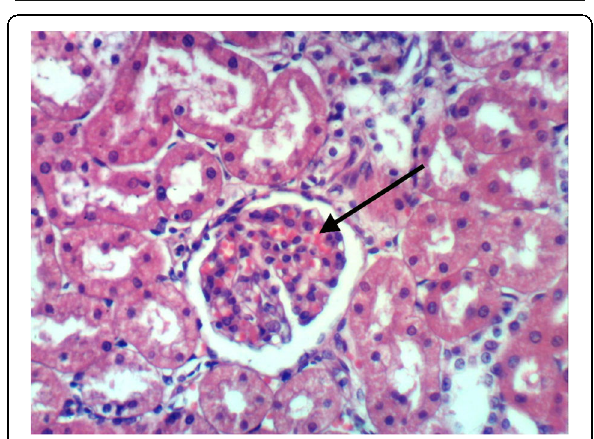
Fig. 14 Photomicrograph of rat ’ s kidney fed on balanced diet supplemented with taurine and vanillin+ oral pot.bromateshowing almost normal structure of renal parenchyma (H&E × 400)